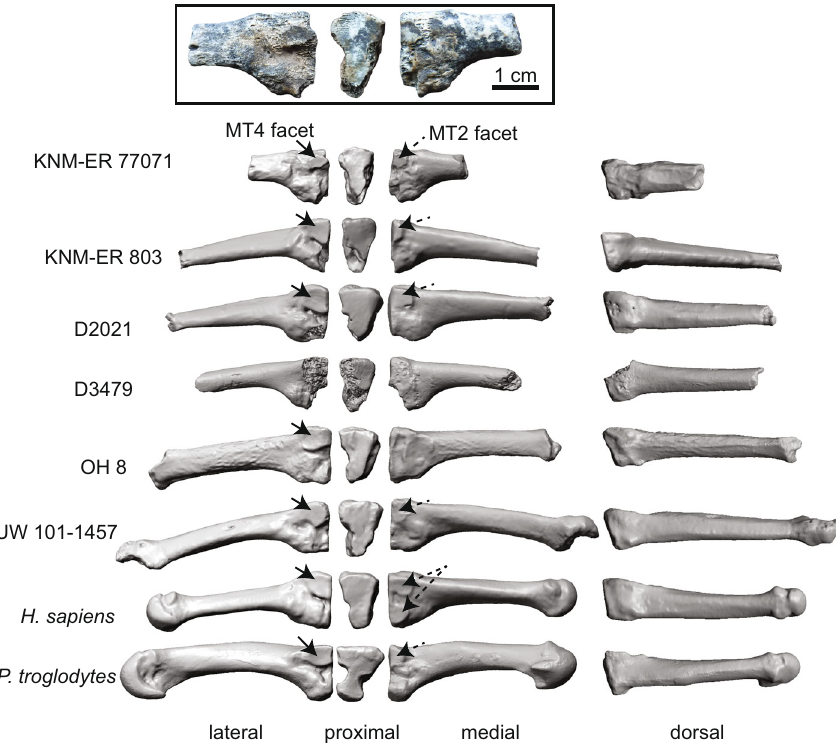
Fig. 5 Proximal 3rd metatarsal anatomy. Proximal left the third metatarsal KNM-ER 77071 is inset to show lateral, proximal, and medial views. Comparative MT3s for Homo erectus (KNM-ER 803, D2021, D3479), Homo habilis (OH 8), Homo naledi (UW 101-1457 68 ), humans, and chimpanzees are shown below in lateral, proximal, medial, and dorsal views. MT4 facets indicated by solid arrows, and MT2 facets indicated by the dashed arrows. Like the other hominin fossils, KNM-ER 77071 has only a single dorsal MT2 facet on the medial side. Metatarsal models scaled to the same height of the base for visual comparison. UW 101-1457, D2021, and D3479 images are mirrored for